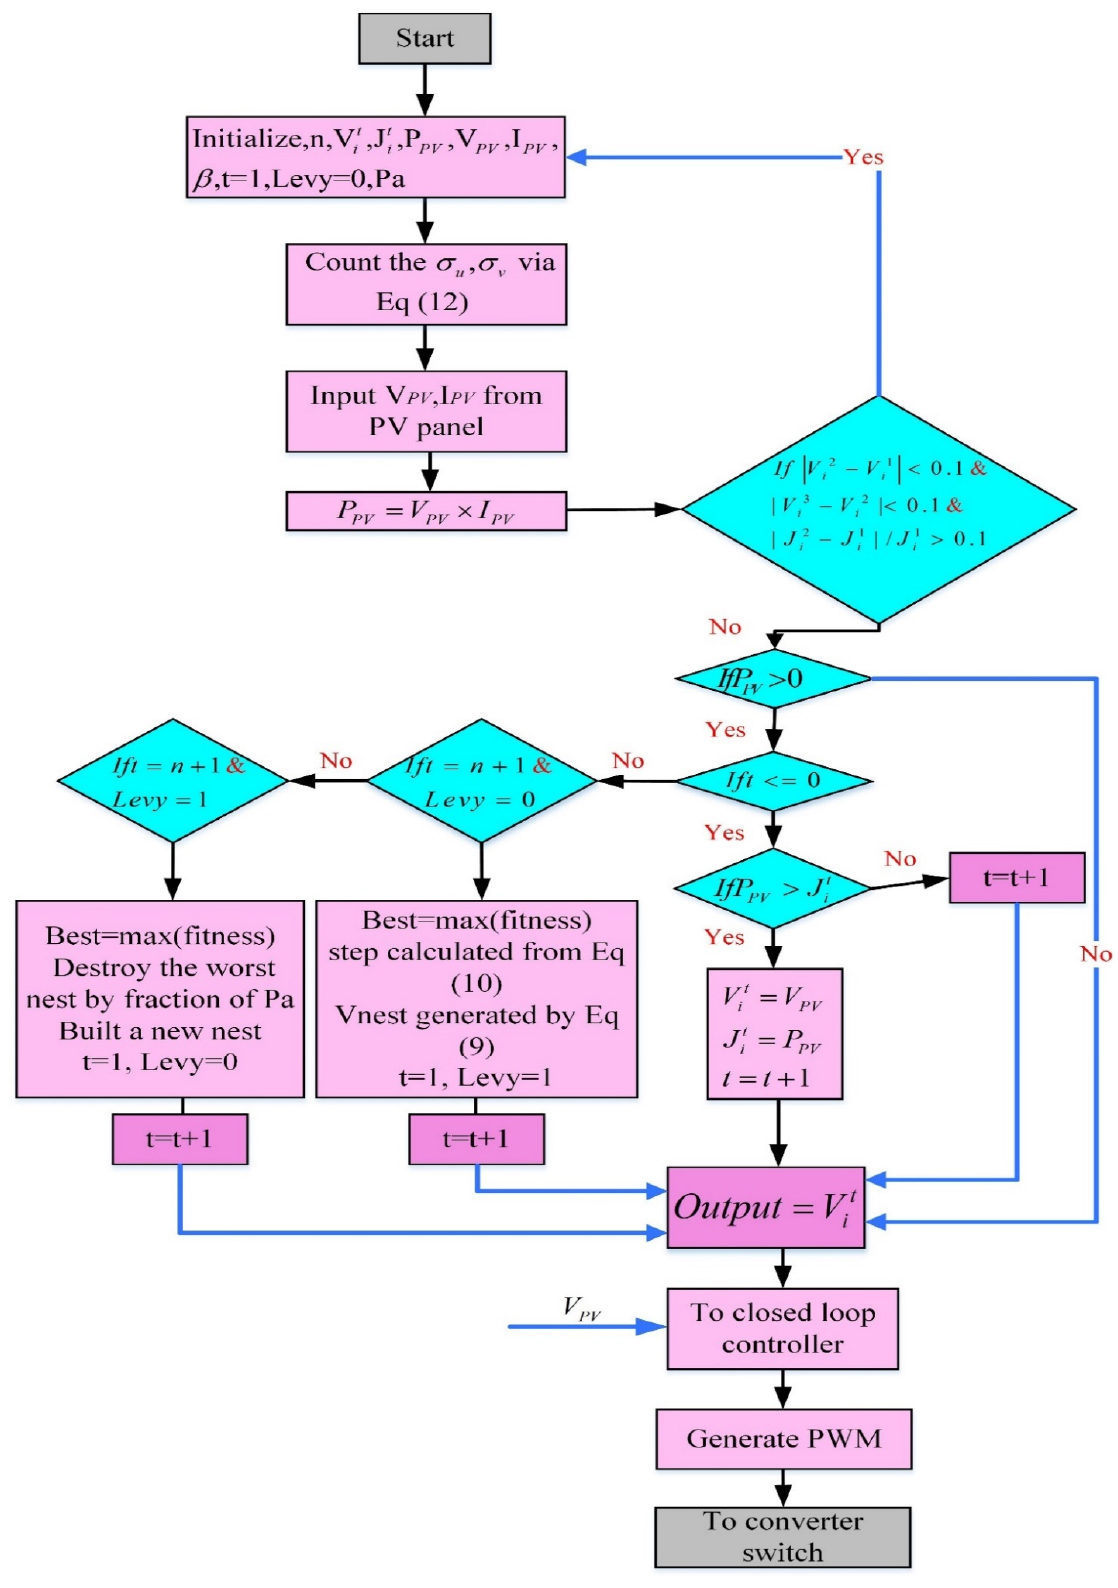
Figure 6. Flowchart of Cuckoo Search Algorithm.